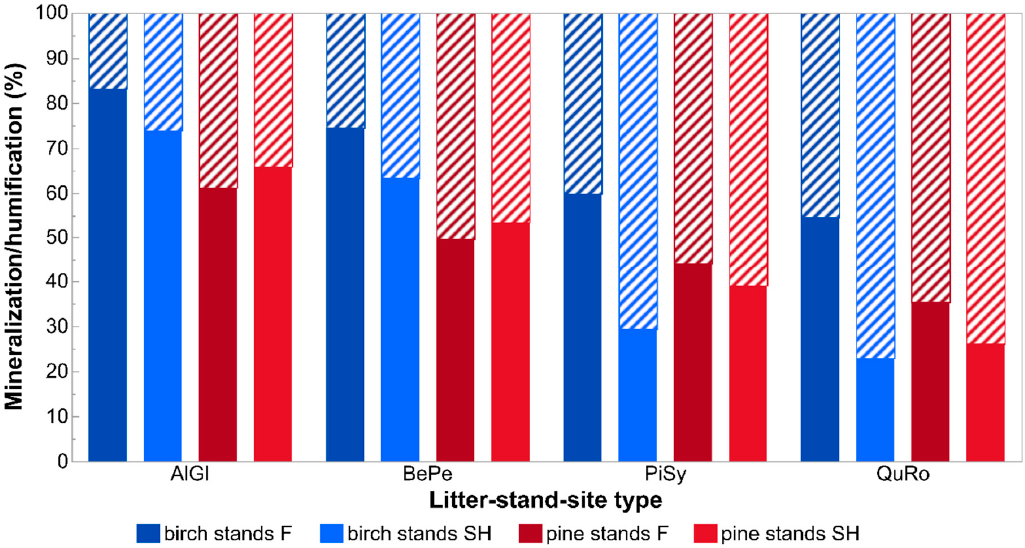
Figure 4. Limit values (LV; full) and litter-to-humus factors (LH; striped) of particular tree species leaf litter in specific stand-site conditions. Abbreviations: AlGl— Alnus glutinosa , BePe— Betula pendula , PiSy— Pinus sylvestris , QuRo— Quercus robur , SH—post-mining external spoil heap site, F—forest